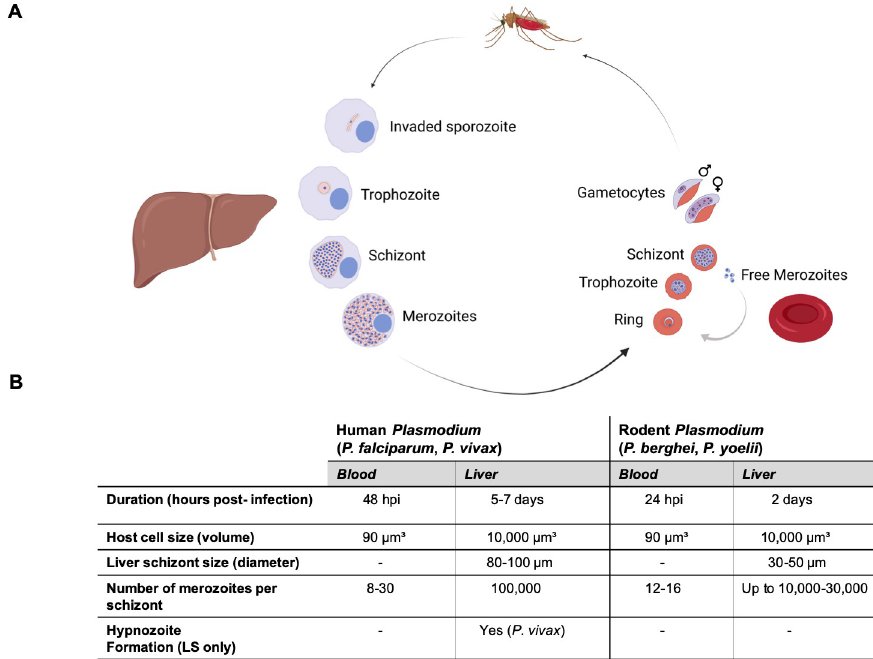
Fig 1. Replication AU : AbbreviationlistshavebeencompiledforthoseusedinFigs 1 to 4 andTable 1 : Pleaseverifythatallentriesarecorrect : of human and rodent Plasmodium parasites during exoerythrocytic and erythrocytic development. (A) Plasmodium life cycle with emphasis on the exoerythrocytic (liver) and erythrocytic (red blood cell) stages within the vertebrate host. Parasite development in the mosquito is symbolized by the depicted mosquito but is not shown. In the scheme, important exoerythrocytic (invaded sporozoite, trophozoite, schizont, and merozoites) and erythrocytic stages (ring, trophozoite, schizont, free merozoites, and gametocytes) are indicated (created with BioRender.com). (B) The table summarizes the main characteristics and morphological features of human ( P . falciparum , P . vivax ) and rodent ( P . berghei , P . yoelii ) Plasmodium parasites. Information is from [36,89,90,126] and also referred in the 2.2.2 section. LS, liver stage.